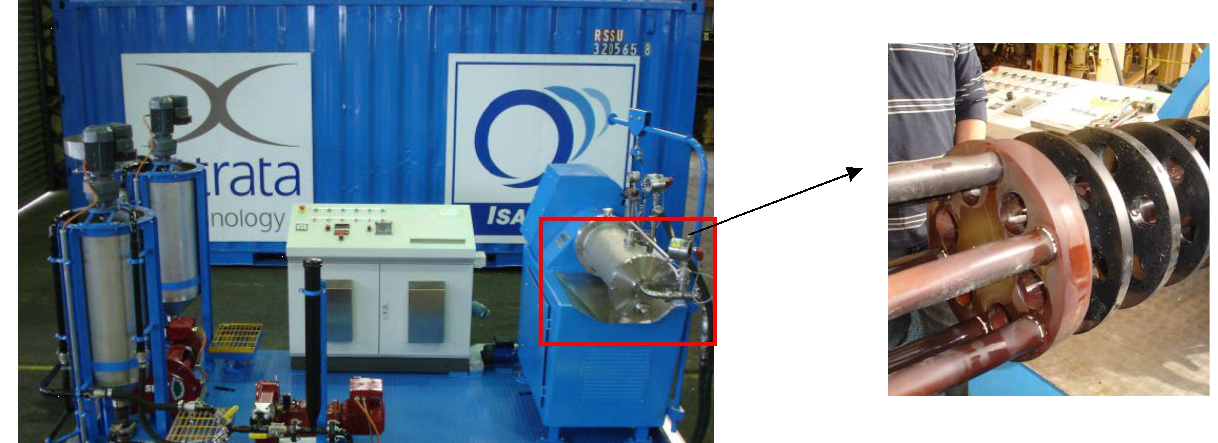
Figure 4. Pilot scale M20 and its internal structure (on the right).